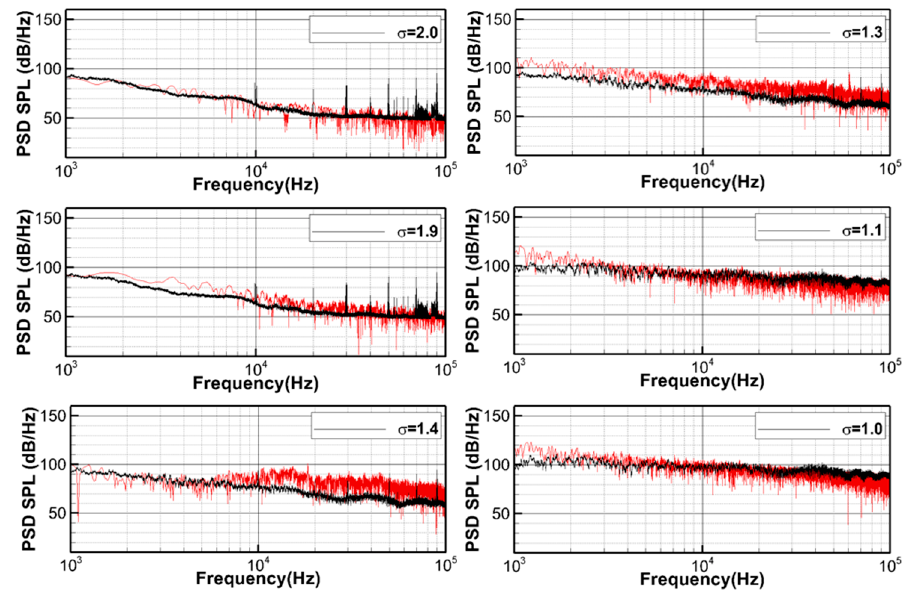
Figure 28. Comparison of acoustic pressure spectrum between numerical and experimental results according to cavitation number: measured spectrum (black line) and numerical result (red line).